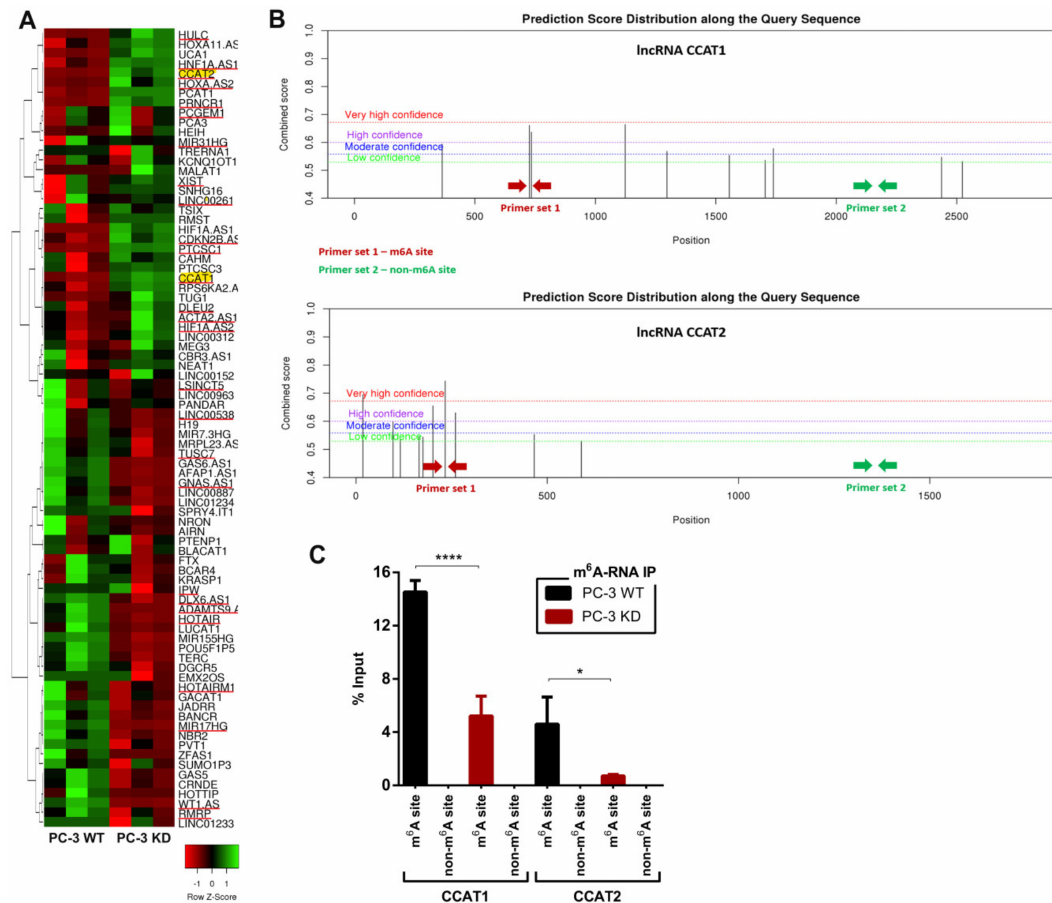
Figure 5. VIRMA expression endorses long non-coding RNAs (lncRNAs) expression in m 6 A-dependent way. ( A ) Heat map and clustering analysis of lncRNAs expression in PC-3 WT and PC-3 KD cells, 3 biological replicates per condition. The 27 lncRNAs di ff erentially expressed are underline red and the selected ones are further highlighted in yellow; ( B ) Potential m 6 A binding sites at lncRNAs CCAT1 and CCAT2 predicted with high and very high confidence (red and purple lines) by SRAMP (http: // www.cuilab.cn / sramp / ) [19]. Red and green arrows indicate the regions corresponding to PCR amplicons used for lncRNA quantification in immunoprecipitation experiments; ( C ) Abundance CCAT1 and CCAT2 transcripts in m 6 A-RNA IP pools from PC-3 WT and PC-3 KD cells. After purification precipitated RNA was used as a template for reverse transcription and real-time PCR with primers as indicated in 5b. Data is represented as percentage of input; **** p < 0.0001 and * p < 0.05, Mann–Whitney U